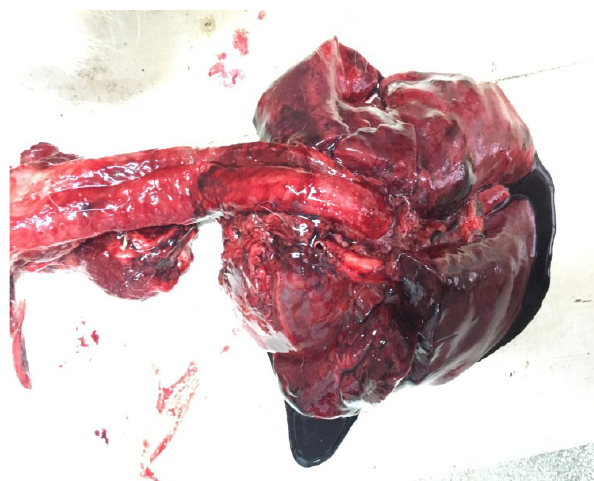
Fig. 9. Lungs of cherry-red color, foamy-bloody fluid was emitted from the lumen of the bronchi